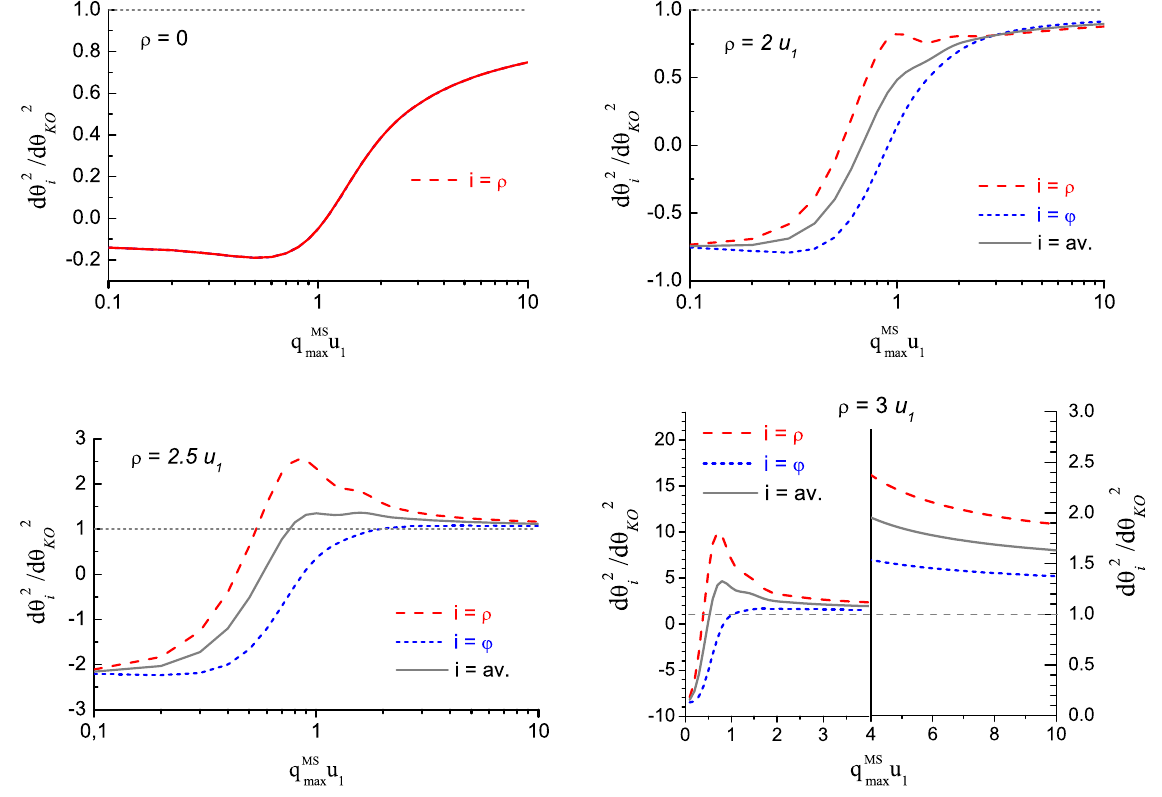
FIG. 6. Mean square angles of the scattering in both radial ( i ¼ ρ ) and azimuthal ( i ¼ φ ) directions along with their average ( i ¼ av .) at ρ ¼ 0 (top left), ρ ¼ 2 u 1 (top right), ρ ¼ 2 . 5 u 1 (bottom left) and ρ ¼ 3 u 1 versus the maximum contributing momentum transfer q MS max (bottom right), plotted as a ratio to the analogous positive values, evaluated using KO ansatz